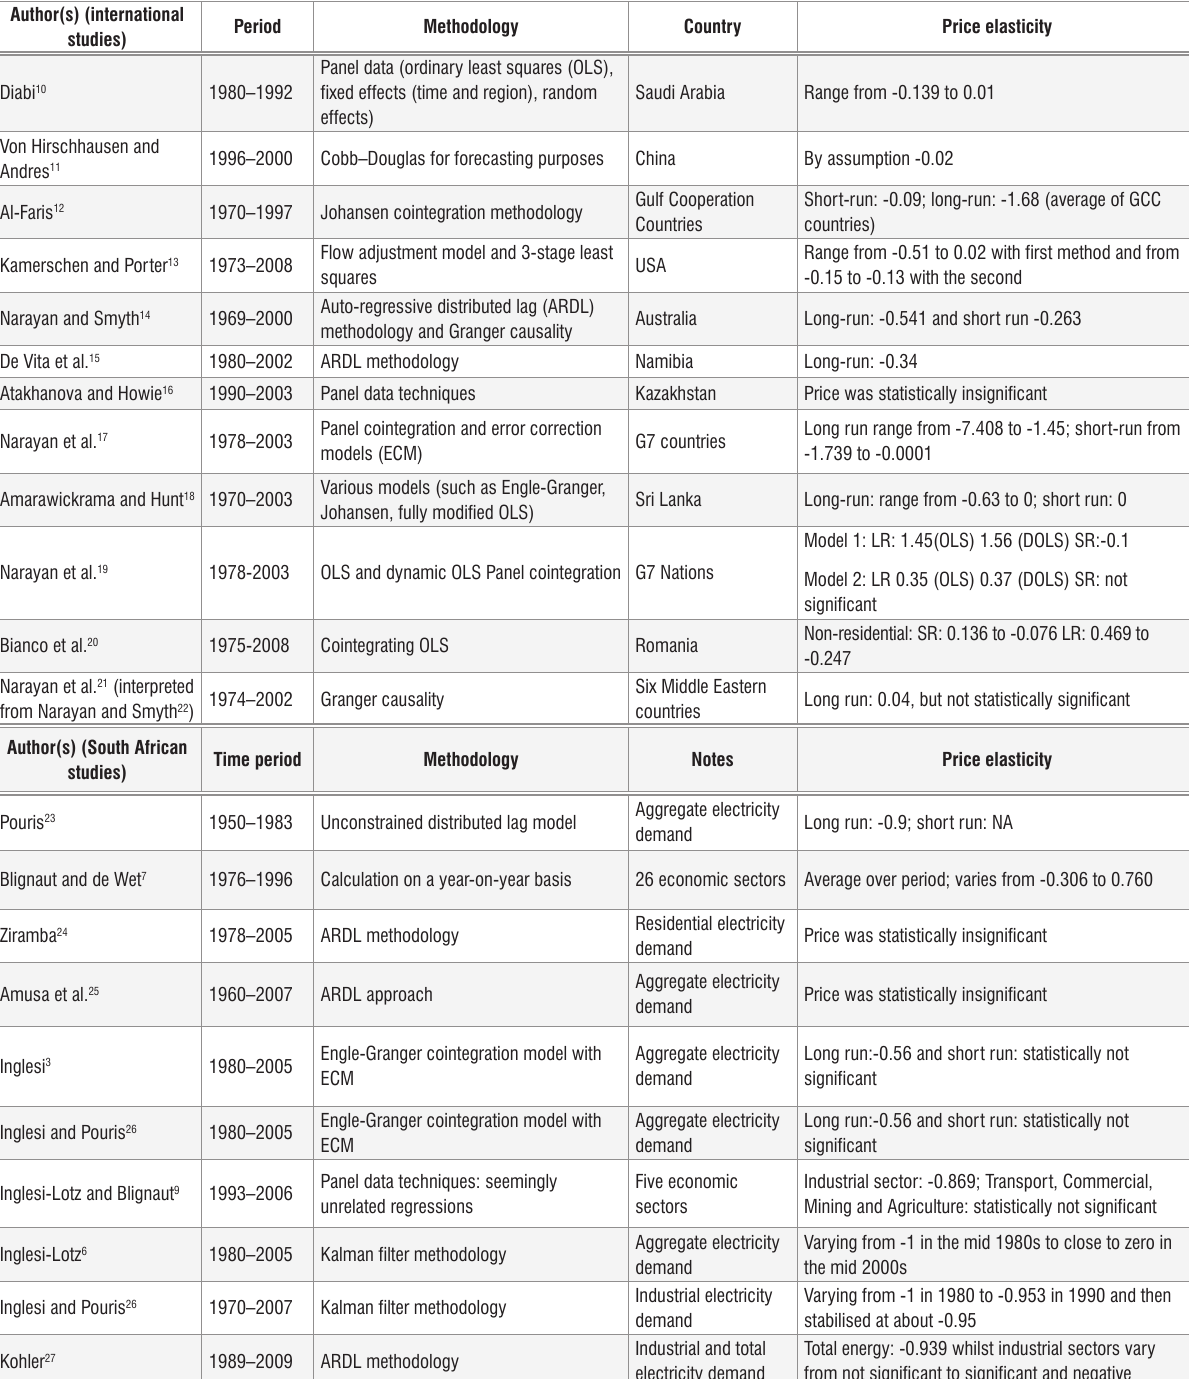
Table 1: Selected international and South African studies on price elasticity of electricity demand Author(s) (international